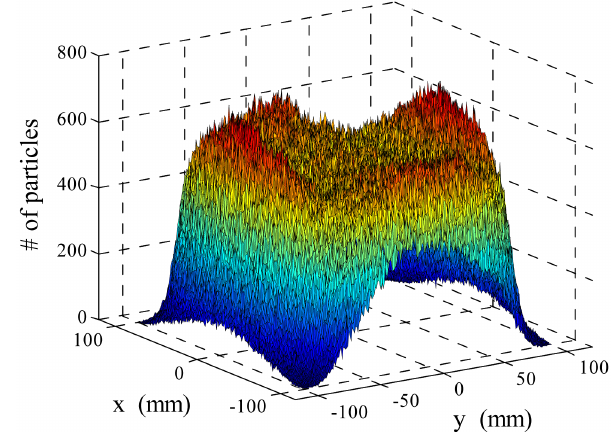
FIG. 27. Expanded and homogenized transverse beam profile at the 10 MeV beam dump entrance.